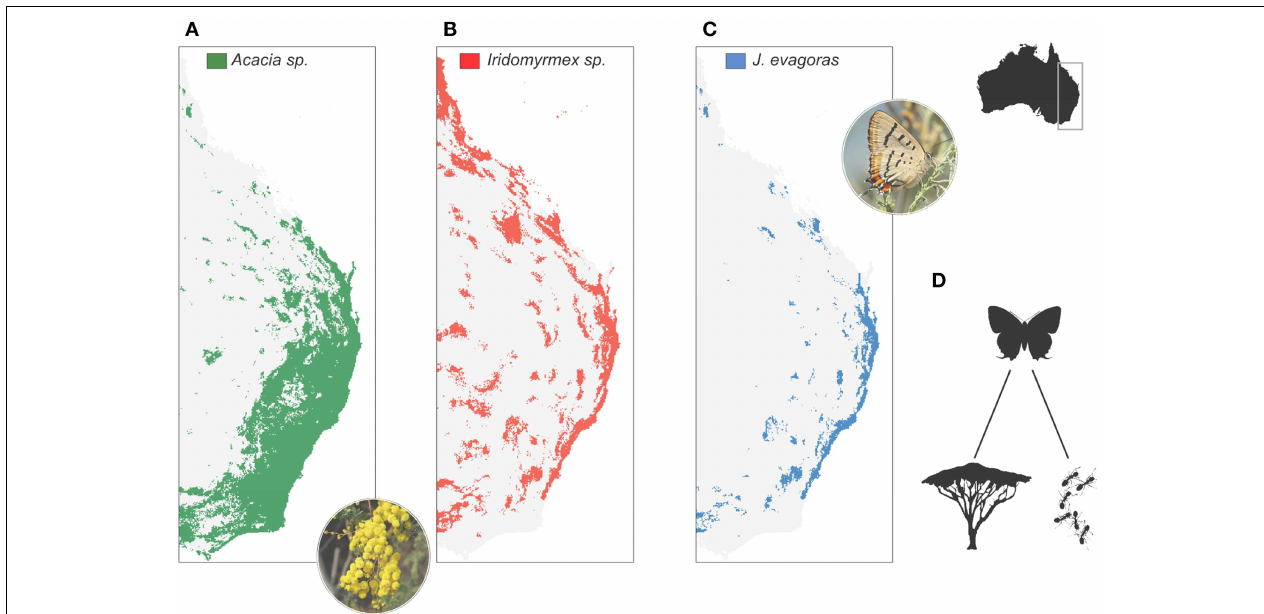
obtained using species distribution models with a random forest statistical approach applied to occurrences from http://www.gbif.org/. Pseudo-absences were generated randomly across Australia. The distribution of J. evagoras was constrained by the forecasted range of the host plants and mutualistic ant species. Acacia spectabilis image by Melburnian [Own work (digital photograph by author)] [CC BY 3.0 (http://creativecommons.org/licenses/by/3.0)], via Wikimedia Commons. Jalmenus-evagoras-ventral image by Benjamint444 (Own work) [GFDL 1.2 (http://www.gnu.org/licenses/old-licenses/fdl-1.2.html)], via Wikimedia